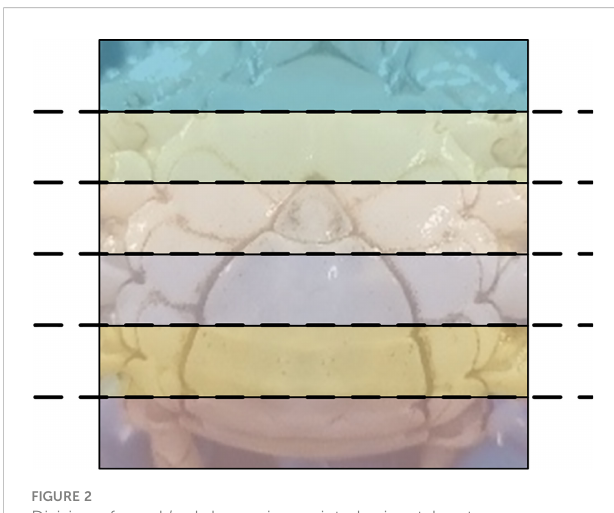
FIGURE 2 Division of a crab ’ s abdomen image into horizontal